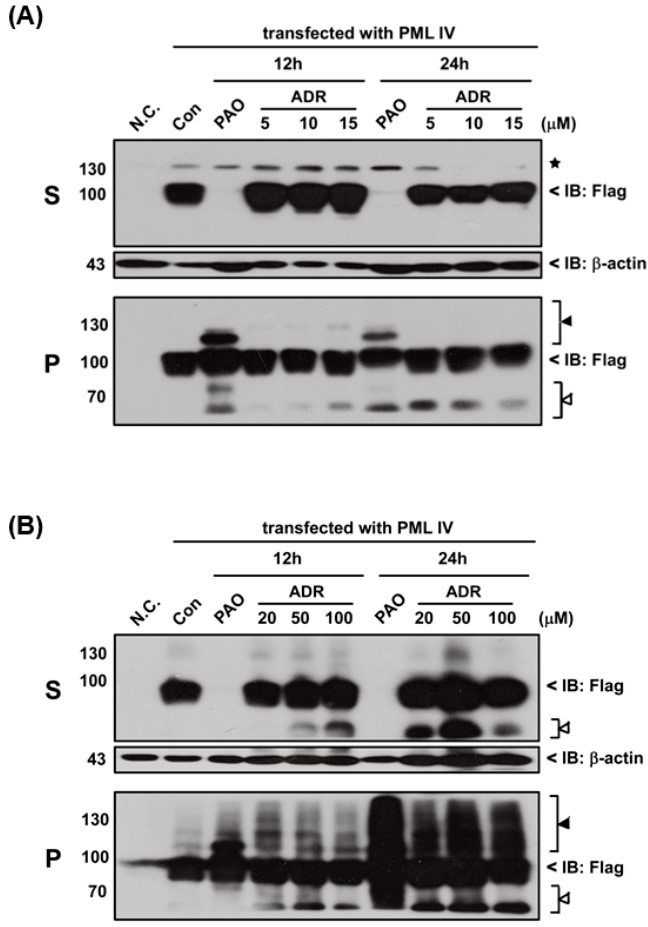
Figure 6. Effect of adriamycin (ADR) on induction of PML-IV protein solubility changes in 293T cells. Flag-PML-IV overexpressed 293T cells were exposed to: ( A ) low (i.e., 5, 10 and 15 µM); and ( B ) high concentrations (i.e., 20, 50 and 100 µM) of ADR for 12 or 24 h. Additionally, in both cases, 4 µM of PAO were also used to compare the effects of PAO with adriamycin on PML-IV protein solubility changes. After treatment, PML-IV protein solubility changes were determined by Western blot with Flag antibody. The star ( ★ ) indicates non-specific protein bands, the white triangle ( △ ) indicates the protein degradation and black triangle ( ▲ ) indicates protein modification.